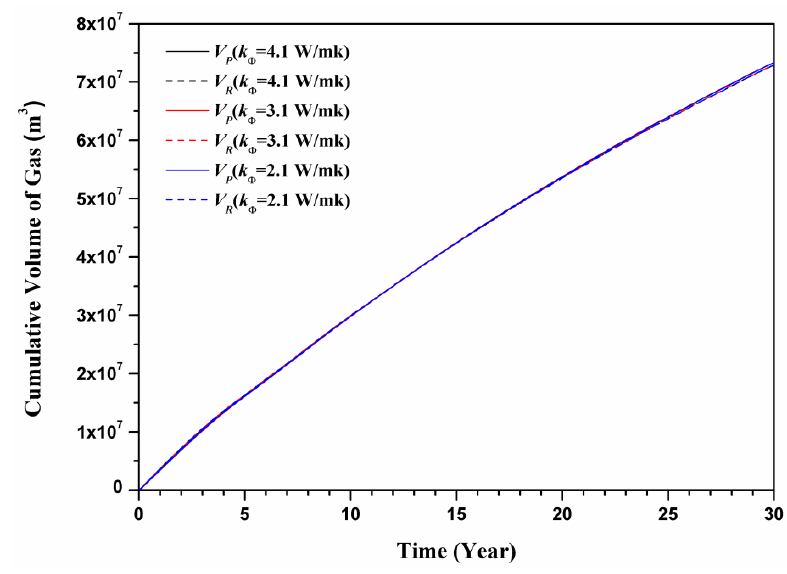
Figure 15. Sensitivity to the thermal conductivity ( k Θ ): evolution of V P and V R overtime.